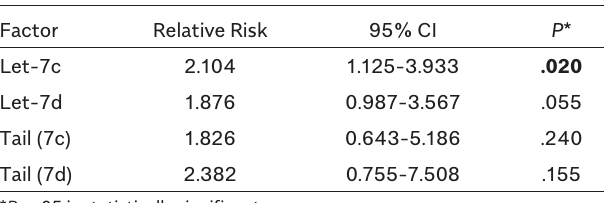
Table 5. Multivariate Survival Analysis (Cox Regression Model) of Clinical Prognostic Factors and Let-7c and 7d Levels in Patients with FOLFIRINOX